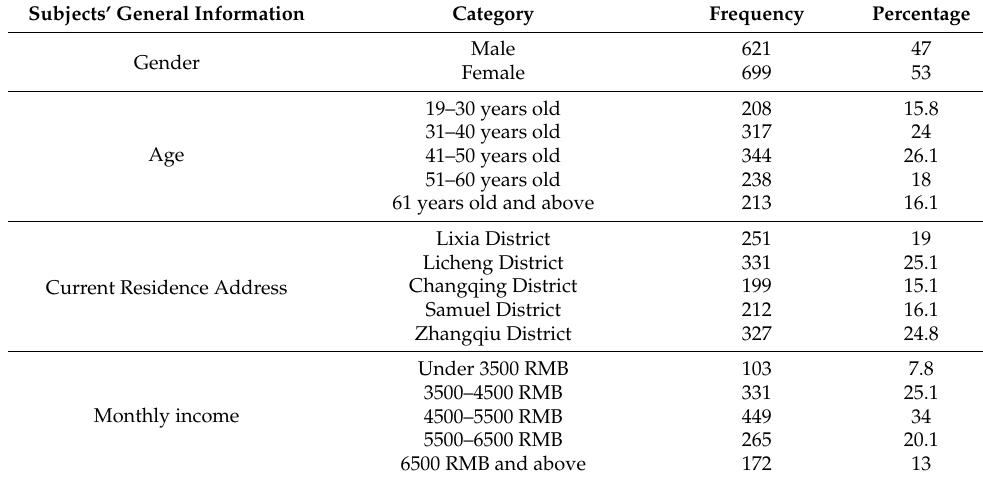
Table 5. Descriptive Statistics of